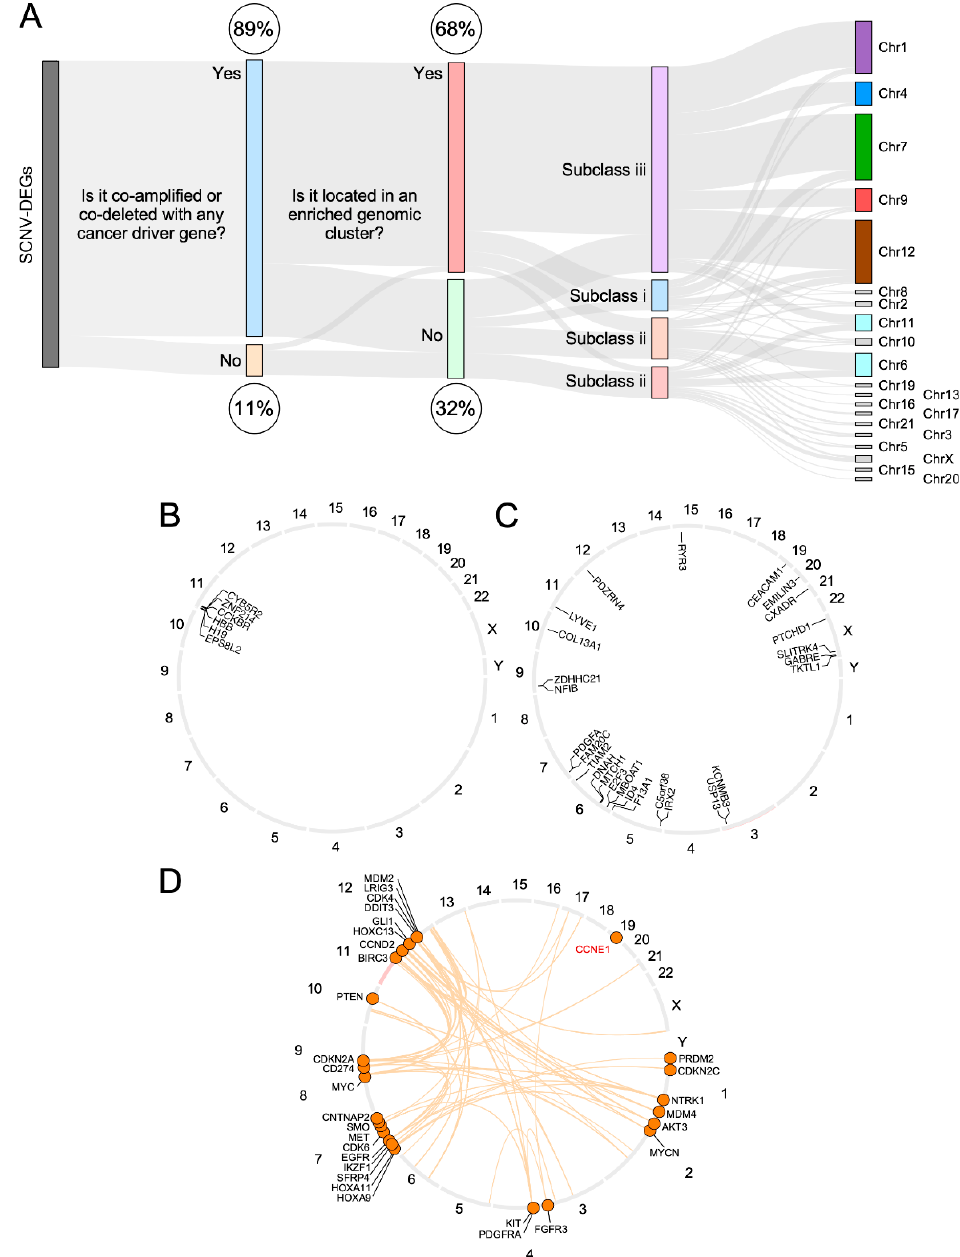
Figure 4. Functional cataloging of SCNV-DEGs in glioblastoma. ( A ) Sankey diagram showing the genomic context associated with CiberAMP-identified SCNV-DEGs in glioblastoma. Chr, chromosome. Subclass i, includes predicted drivers (SCNV-DEGs containing known proto-oncogenes or tumor suppressor genes); Subclass ii, includes two types of putative drivers: (a) SCNV-DEGs not associated with concurrent copy number variations in known cancer driver genes. (b) SCNV-DEGs concurrently amplified or deleted with SCNV-DEGs encoding cancer drivers located in different chromosomes; Subclass iii, includes SCNV-DEGs with uncertain functional relevance. See further information in the main text. ( B – D ) Genomic localization of indicated SCNV-DEGs that were cataloged as functionally interesting (subtype ii) according to our genomic context-based classification criteria (see main text for more details). Co-amplifications and co-deletions with these oncogenes are represented by arched brown